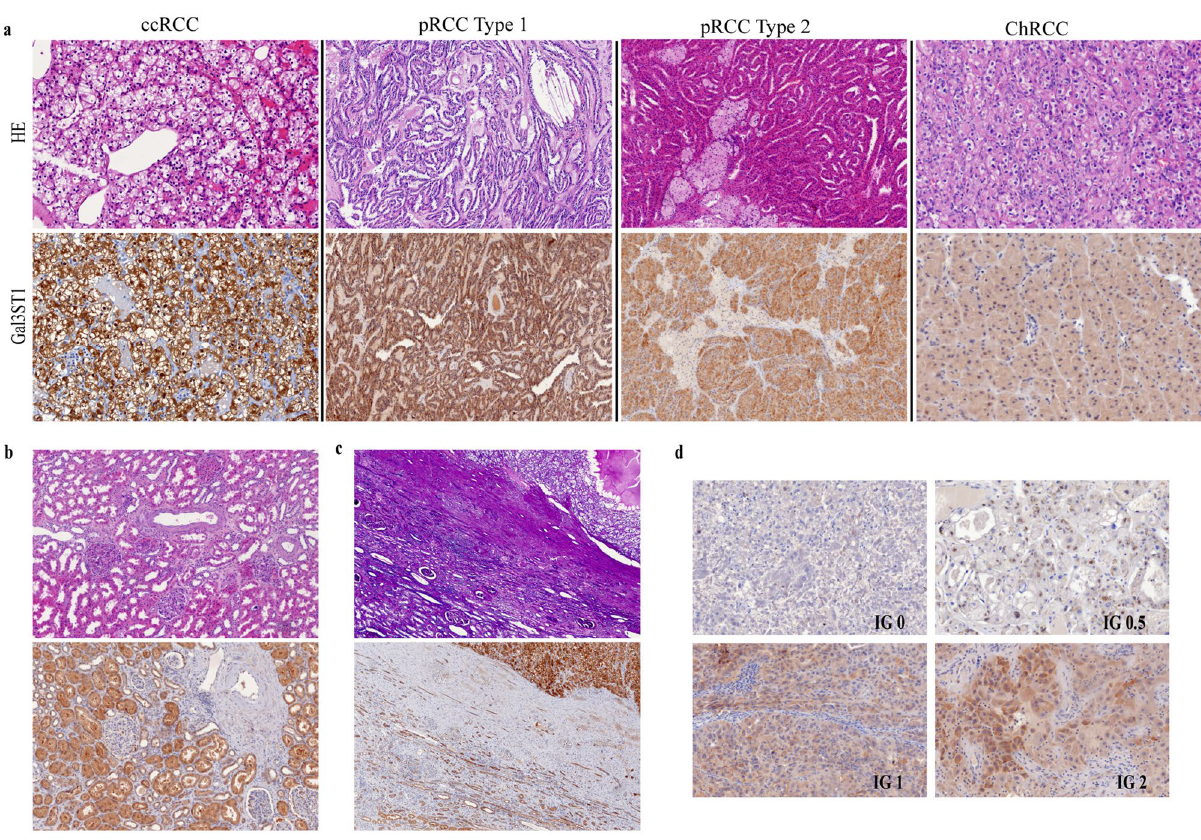
Figure 1. Immunohistochemical expression of Gal3ST1 in renal cell carcinoma. ( a ) cytoplasmatic and partially membranous positivity for Gal3ST1 could be observed in all common types of RCC. In this figure, Gal3ST1 expression in ccRCC and pRCC (type 1 and 2) was evaluated as highest intensity grade (IG = 3) and in shown ChRCC as IG = 1. ( b ) tumor-free kidney tissue typically shows physiological Gal3ST1 positivity of (proximal > distal) tubuli and negativity of glomeruli, interstitium and blood vessels. ( c ) peritumoral fibrotic tissue (mid part of the photomicrograph) is typically Gal3ST1 negative, while tumor (upper right corner)